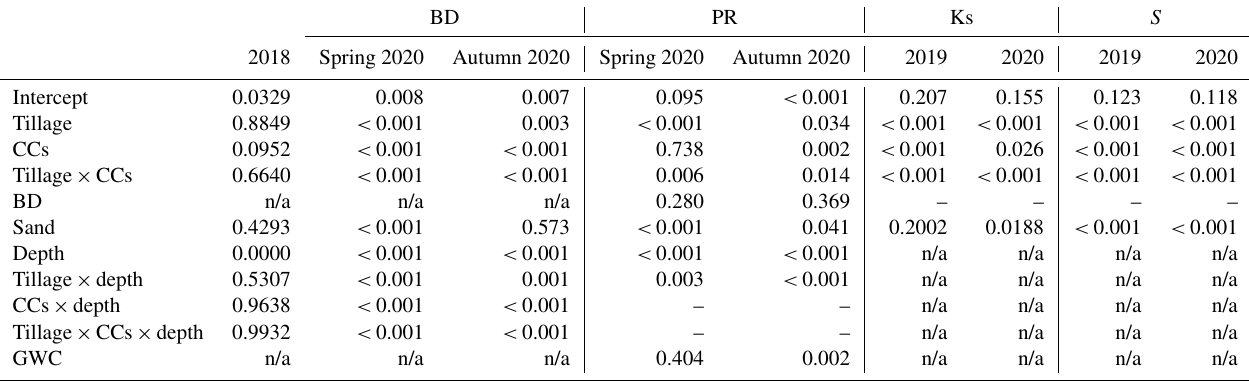
GWC The dash (–) indicates the effect not included in the model according to the Akaike information criterion. n/a stands for not